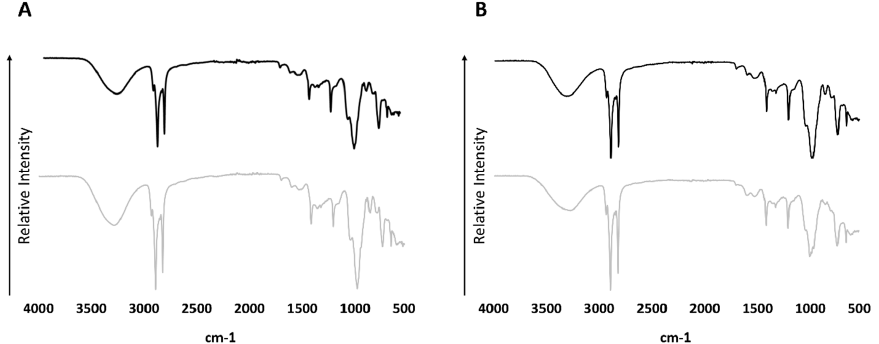
Figure 3. Representative Fourier-Transform Infrared Spectroscopy (FT-IR) spectra of matched unheated ( black ) and heated ( grey ) samples with heating to 60 °C ( A ) or 185 °C ( B ).